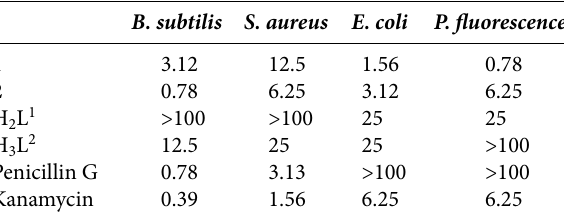
Table 4. MIC values ( μ g mL –1 ) of the compounds B. subtilis S. aureus E. coli P.